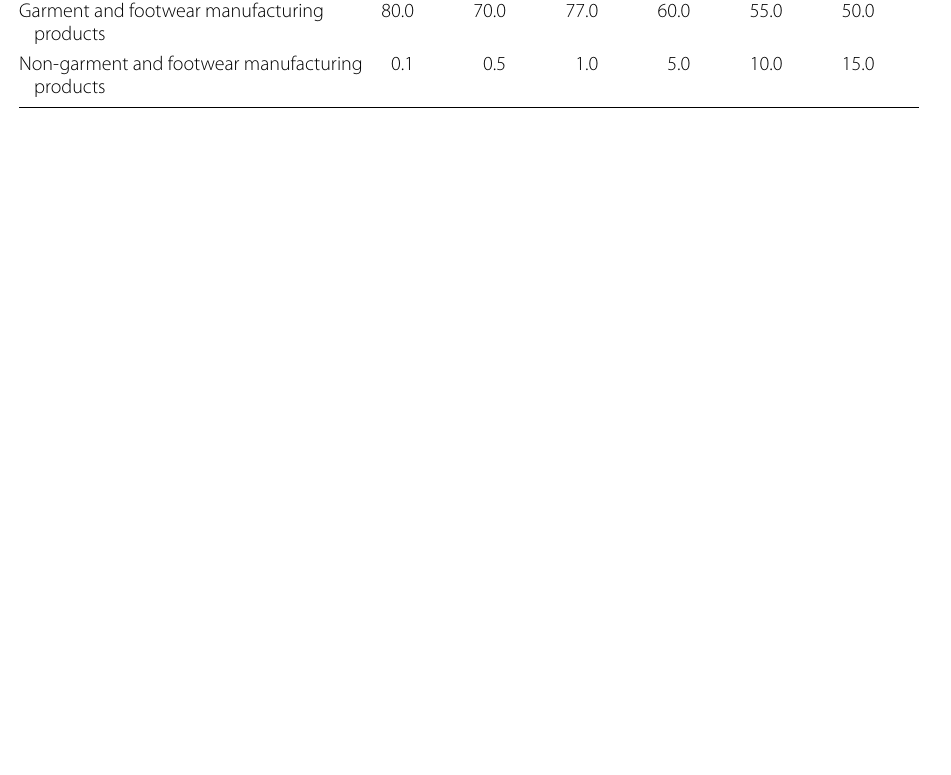
Table 8 Target share of export sectors (percentage in total exports). Source : Industrial Development Plan 2015–2025 (RGC 2015) Sector Processed agricultural